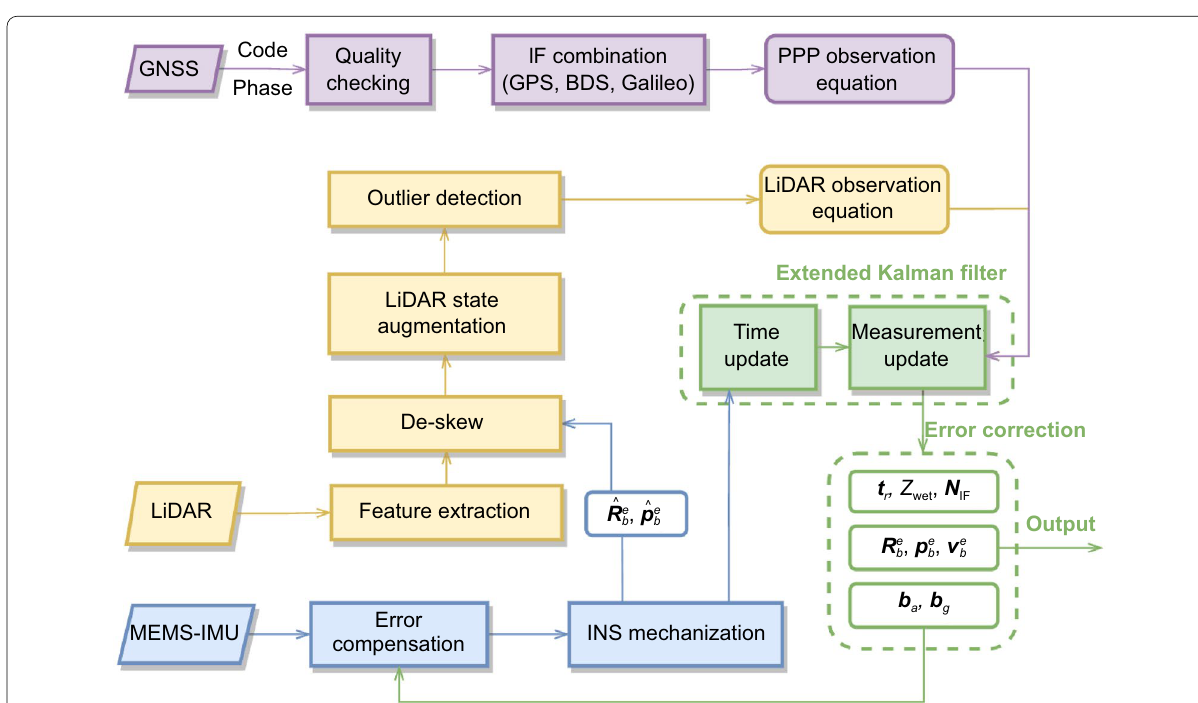
Fig. 2 Flowchart of the GIL